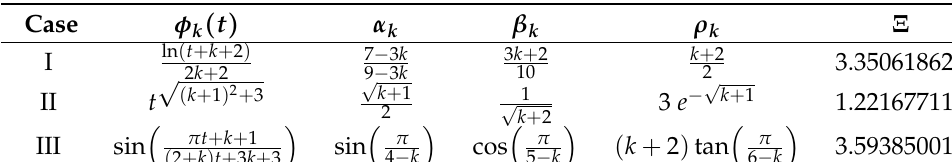
Table 4. The values of φ k ( t ) , α k , β k , ρ k , and Ξ .